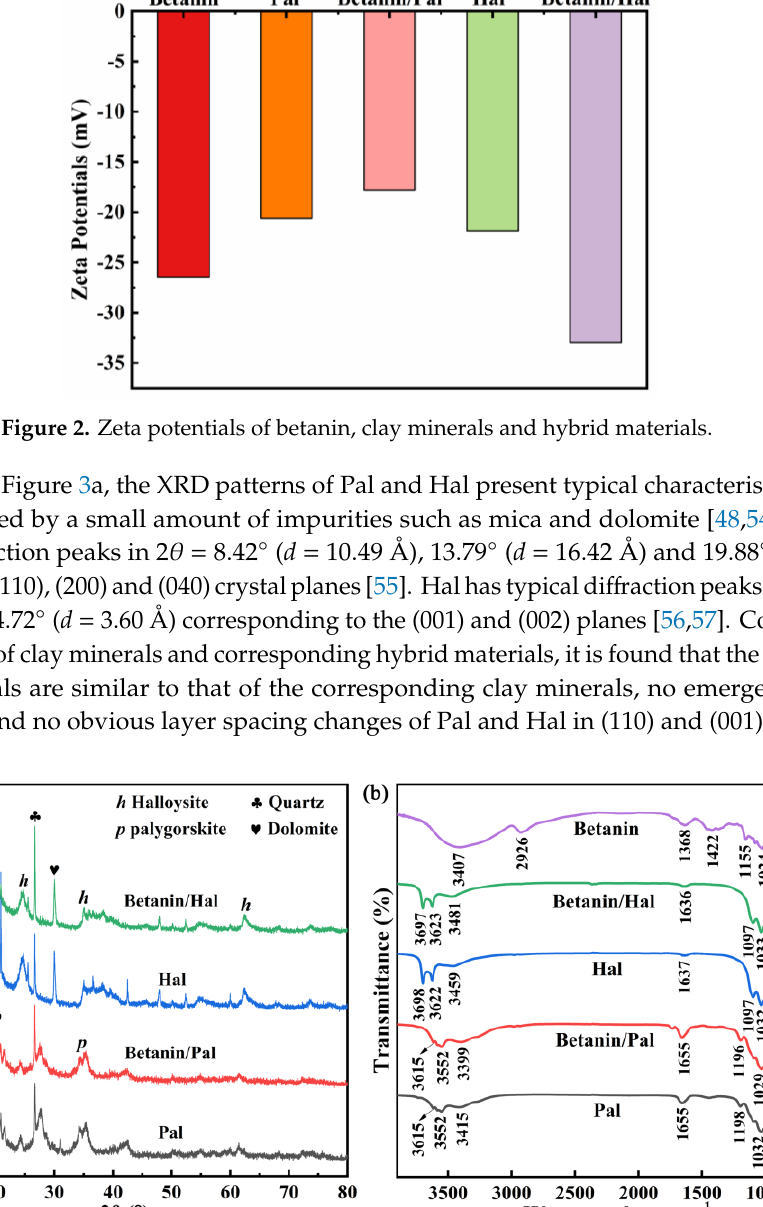
Table 1. Pore structural parameters of the raw clay minerals and hybrid materials. Samples